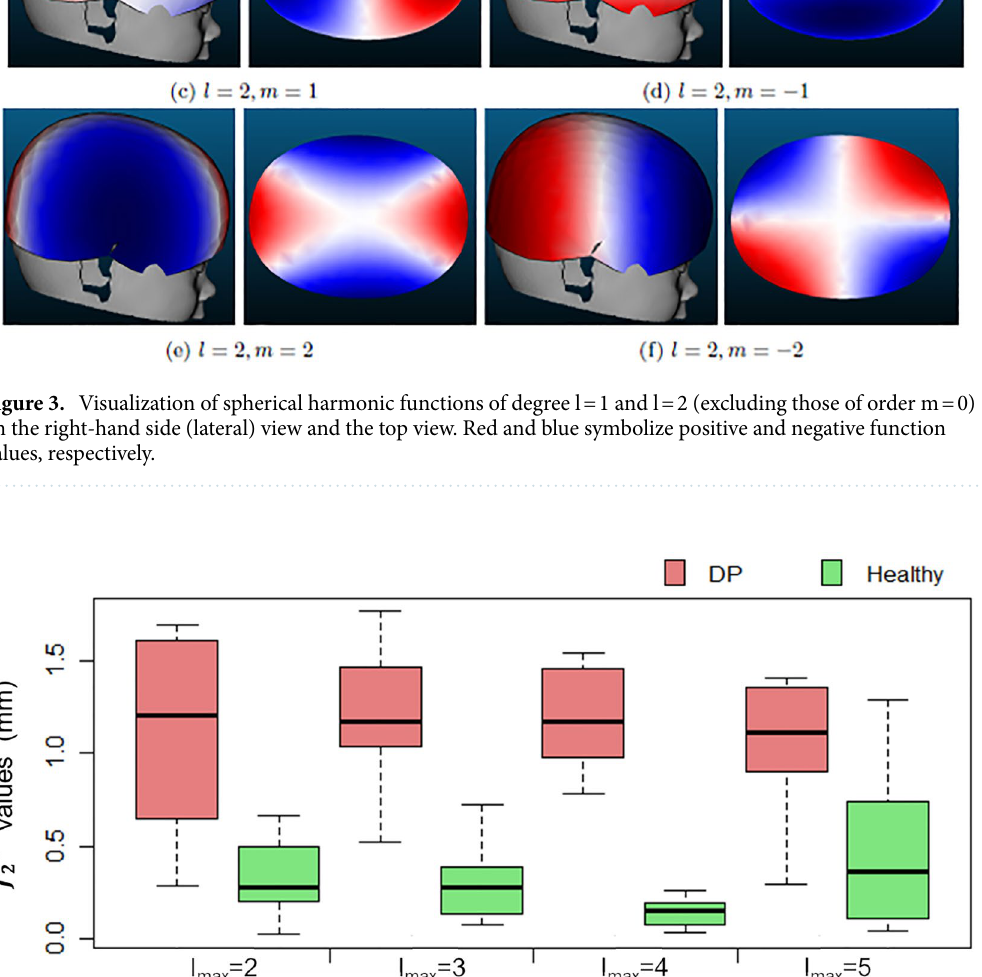
Figure 4. Boxplots of the absolute values of f regular heads and heads with